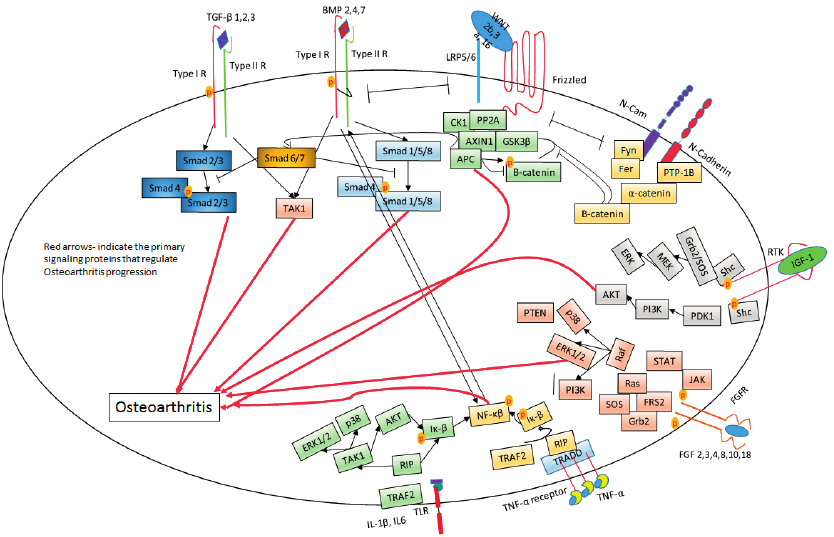
Figure 2. Signaling cascades involved in Osteoarthritis. Red arrows indicate the primary signaling protein that regulate OA progression. The black arrows signify the activation of the proteins. The bars indicate inhibition of the